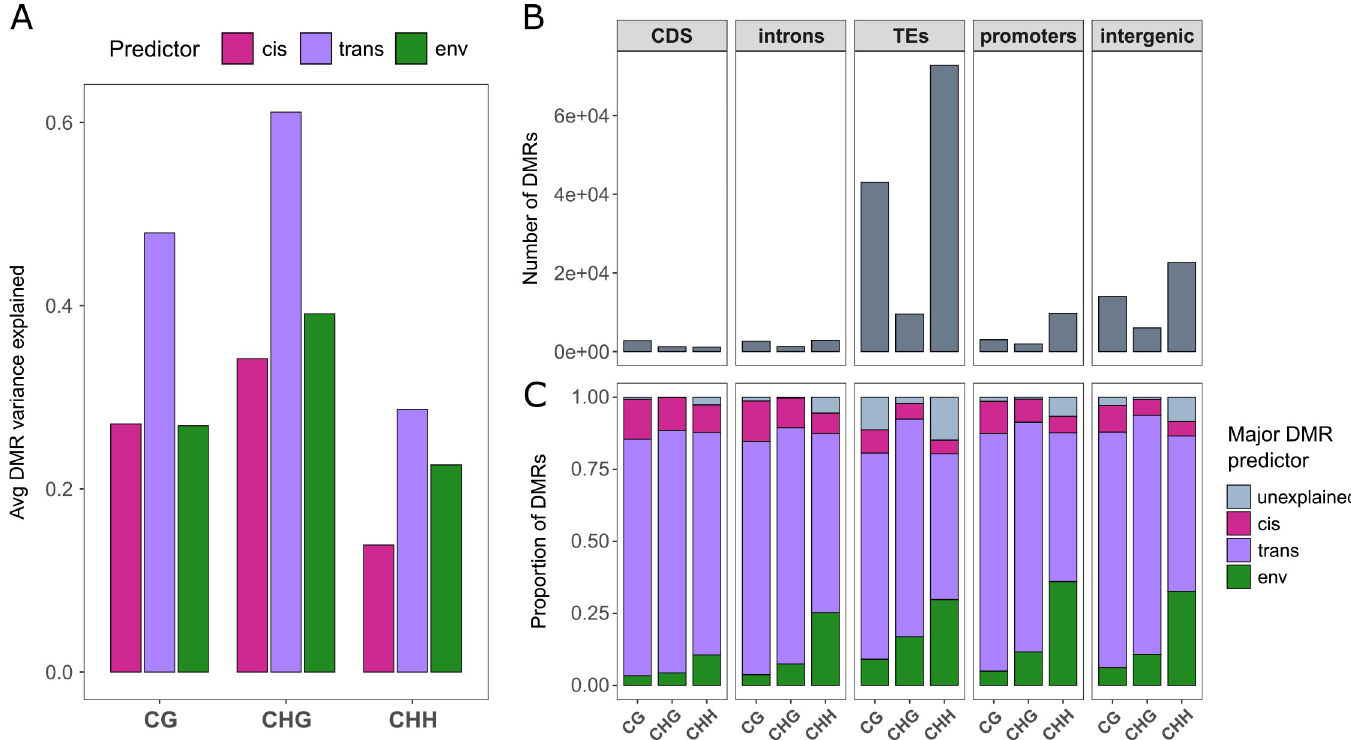
Fig 5. Genetic versus environmental predictors of DMR variance. (A) The variance in DMR weighted methylation explained by genetic similarity in cis , genetic similarity in trans and climatic similarity, averaged across all DMRs. (B) The number of DMRs identified in different genomic features and sequence contexts, and (C) the fractions of these individual DMRs where cis -variation, trans -variation or climatic variation are the major predictors. DMRs where none of the three predictors explained > 10% of the variance are classified as “unexplained”.